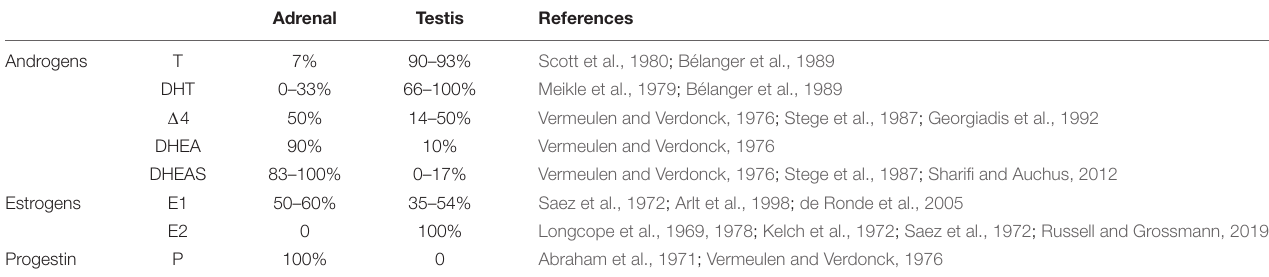
TABLE 1.1 | Glandular sources of sex steroids in men. Adrenal Testis